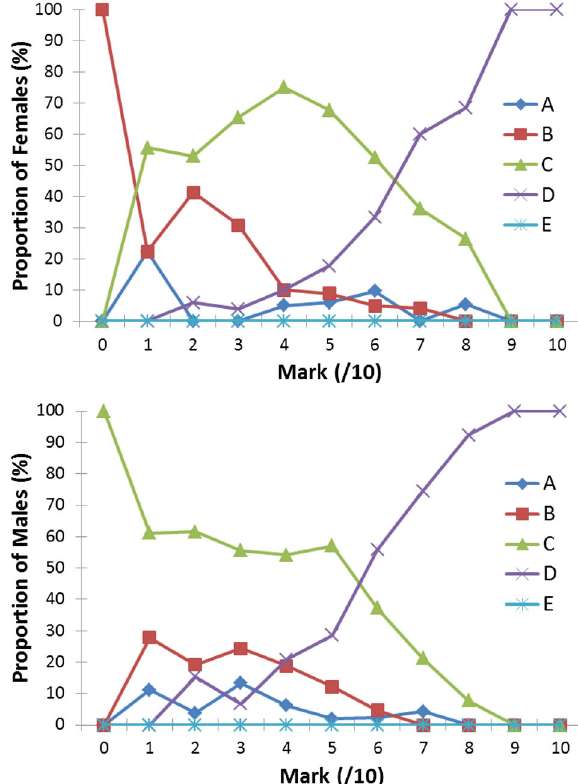
FIG. 3. Item response curves for the 2012 version of the force on a projectile in vertical motion question (FCI question 13), for females (top) and males (bottom). The horizontal axis shows the students ’ scores; the vertical axis is the proportion of students with that score choosing each of the five possible answers.